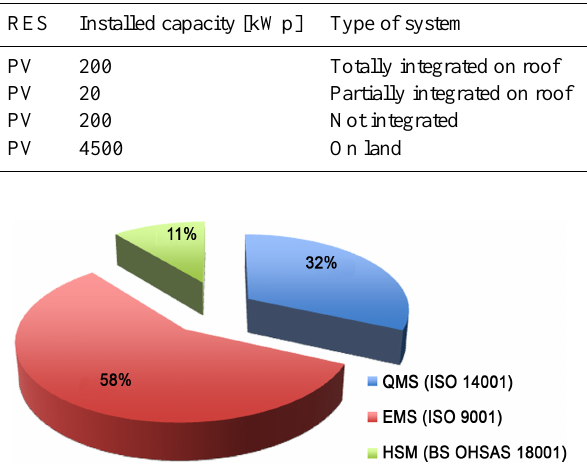
Figure 10. Percentage distribution of the different accreditation schemes of industrial processes (Source: CNR-IMAA elaboration on ACCREDIA